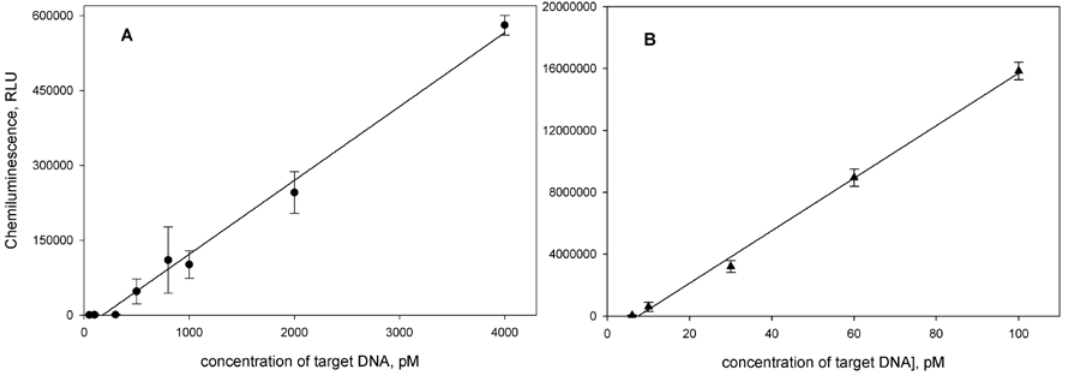
Figure 7. Calibration curves for HBV DNA detection by chemiluminescent sandwich assays using ( A ) HRP-REP conjugate and ( B ) biotinylated REP/Stp-HRP as signaling systems ( n = 3).